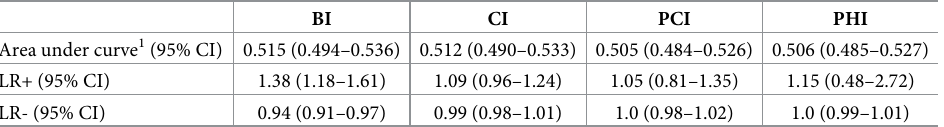
Table 4. Predictive utility of vector indices at household